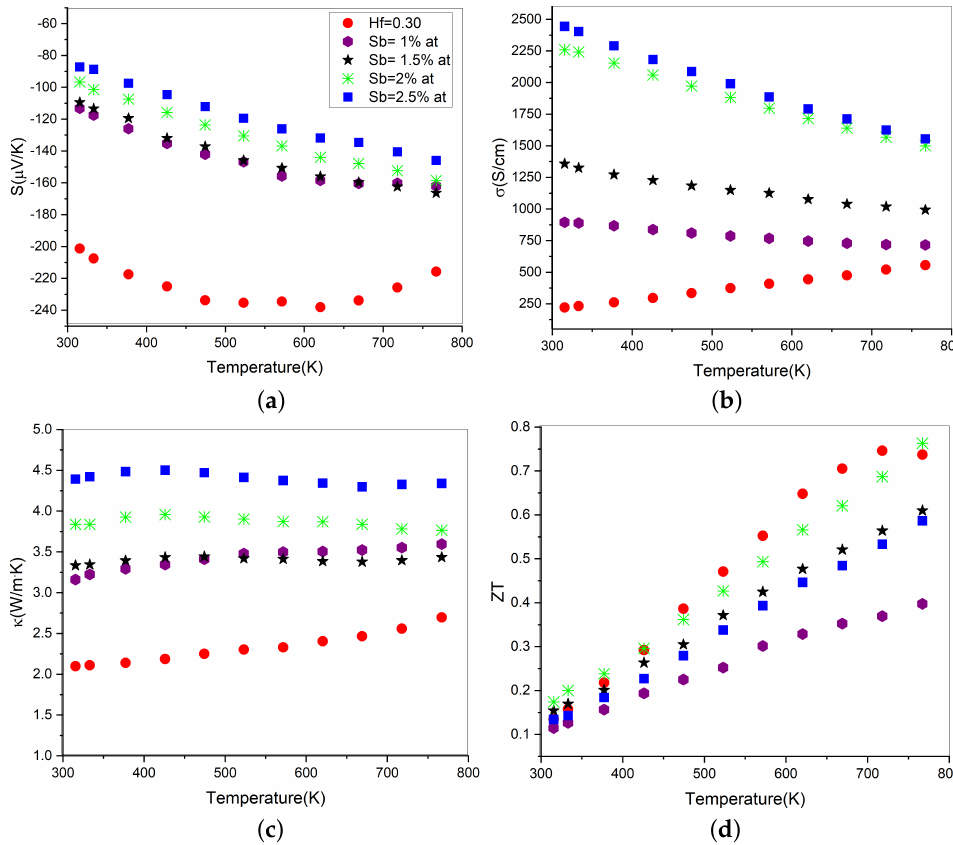
Figure 9. ( a ) Seebeck coefficient, ( b ) Electrical conductivity, ( c ) Thermal conductivity, and ( d ) Figure of merit of Sb-doped (Ti 0.4 Zr 0.6 ) 0.7 Hf 0.3 NiSn